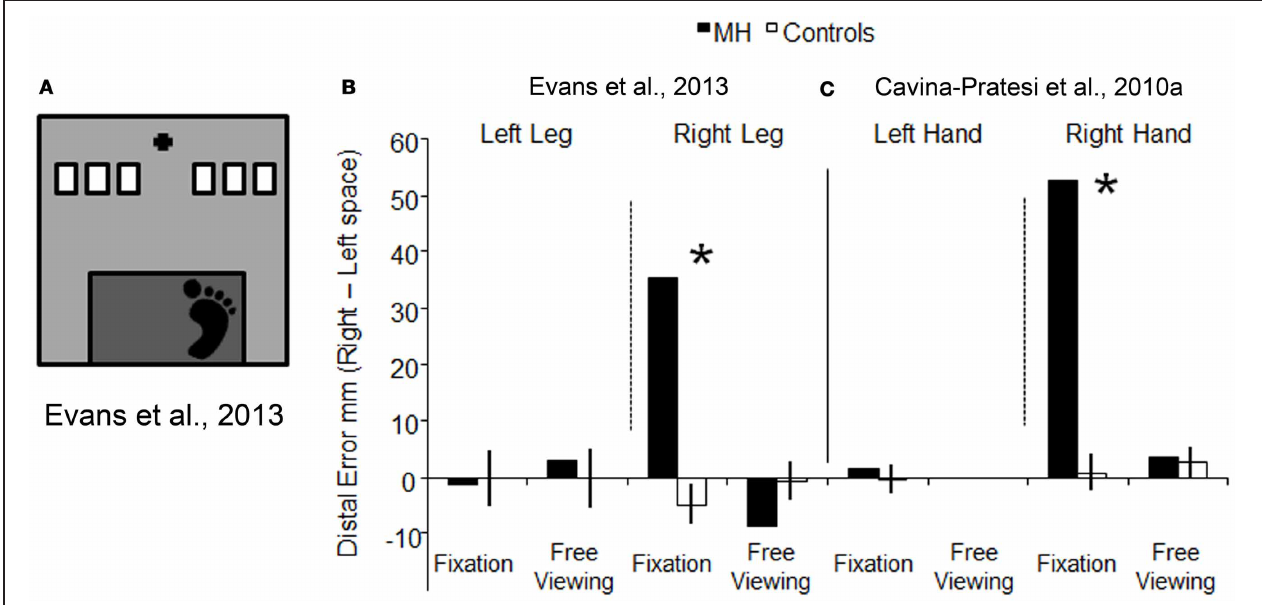
FIGURE 5 | Schematic representation of the set-up used for testing reaching with the lower limb, and a comparisonbetween the results obtained withlower vs. upperlimbs. (A) is a schematic representations of theset-upusedEvansetal.(2013).Theblackcrossdepictsthefixationpoint,the white rectangles show the possible target locations (only one target at a time waspresented), andthedark grayrectangle indicates theedge ofthestep from which participants stepped down to make a “leg-reach.” Graph (B) represents the reaching error (the distance between the target and the landing position of the foot) for the left and right leg in conditions of fixation and free viewing, for